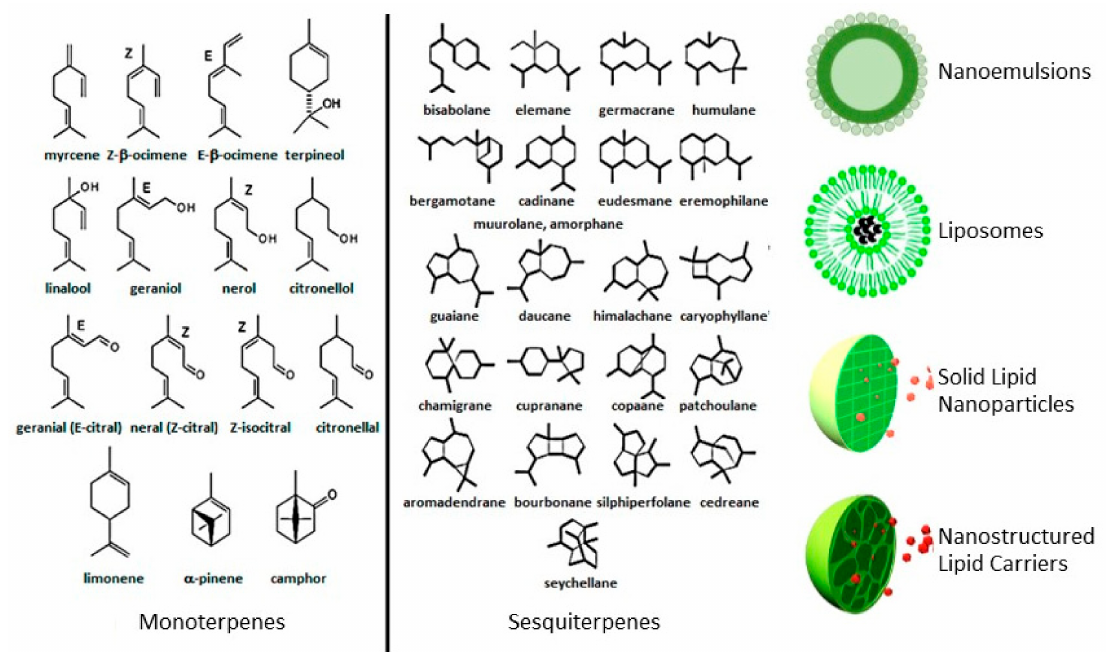
Figure 3. Main lipid-based delivery systems for EOs delivery. Reproduced with permission from [151].